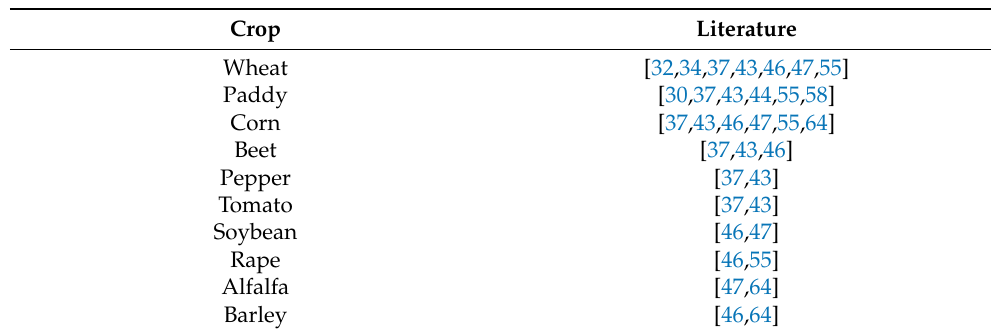
Table 15. Crops and the